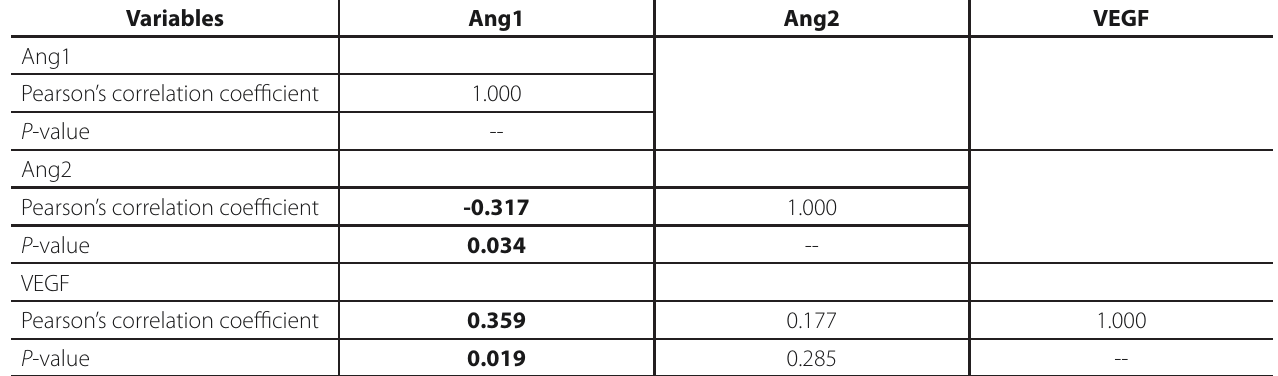
Table 5. Correlations among plasma levels of Ang1, Ang2, and VEGF in VHD